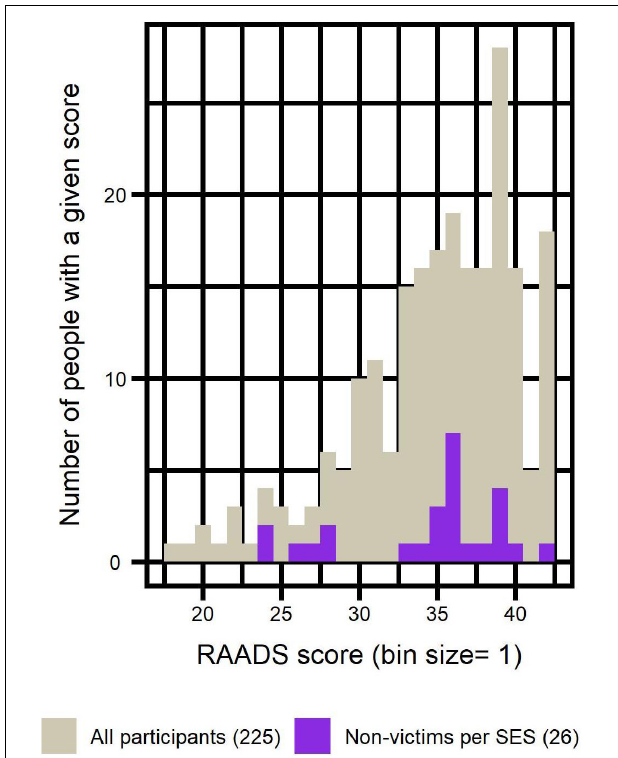
FIGURE 8 | Distribution of RAADS scores of non-victims (per SES) compared to distribution of RAADS scores of all participants.